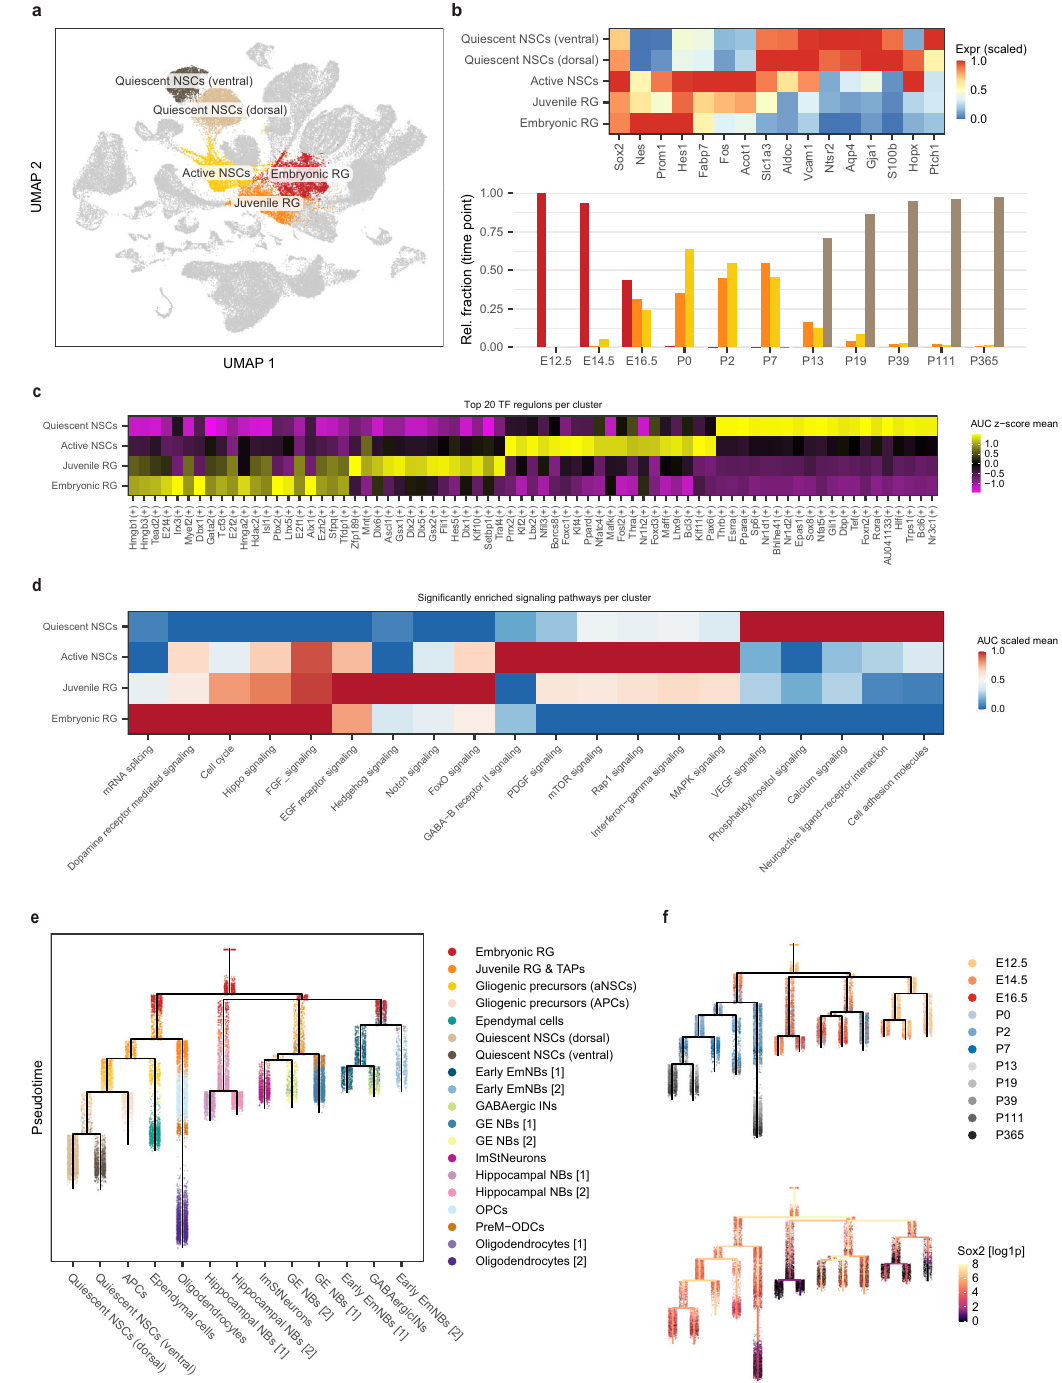
Fig. 2 Temporal distribution of precursor cells throughout development. a Two-dimensional UMAP plot highlighting the main precursor populations identi fi ed across the 11 developmental timepoints. Each dot represents a single cell and colours correspond to the distinct precursor cell types. b Top: heatmap of the main marker genes used to differentiate/annotate the precursor clusters. Shown on the bottom panel is a bar plot showing the normalized relative fraction of the four precursor cell types grouped by timepoint. Colours correspond to the 4 distinct cell types (red: embryonic RG – orange: Juvenile RG – yellow: active NSCs – brown: quiescent NSCs). c Heatmap generated from the SCENIC analysis of the 4 precursor populations showing the top TF regulons per cluster. Colour scale indicates the mean regulon score. d A heatmap showing the signi fi cantly enriched signaling pathways in each of the 4 precursor populations. Colour scale indicates the scaled mean AUC score. e Lineage tree of the neuronal/glial cells within the atlas constructed using URD (see Methods). Each dot represents a single cell and colours correspond to the distinct clusters/cell types. f Top: lineage tree of the neuronal/glial cells within the atlas as in ( e ) but coloured by timepoint. Each dot represents a single cell and colours correspond to the different timepoints. Shown on the bottom is the log1p-expression of Sox2 overlaid on the lineage tree of the neuronal/glial cells. Each dot represents a single cell and the colour scale re fl ects the gene expression level. Source data are provided as a Source Data fi le. Abbreviations as in Fig. 1.